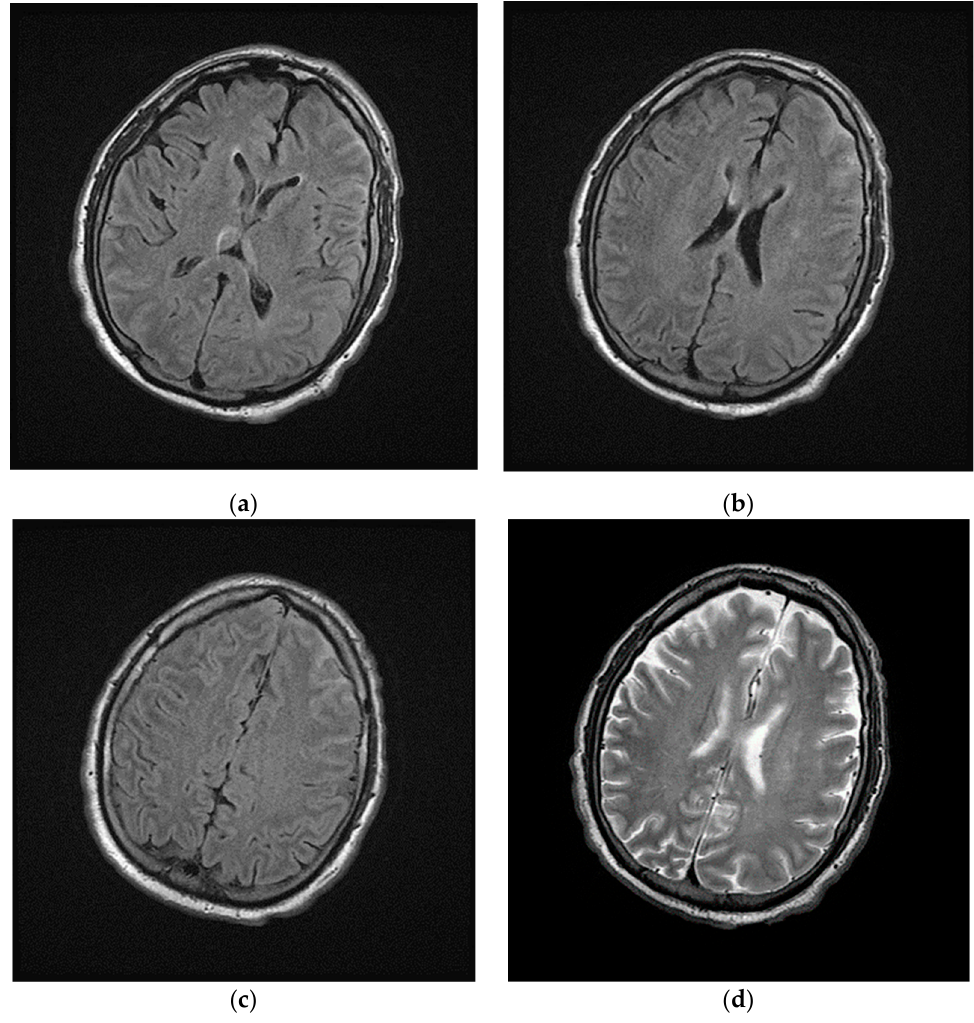
Figure 2. Magnetic Resonance Imaging (MRI) of brain performed during intensive care. ( a – c ) Axial fluid-attenuated inversion recovery (FLAIR) images and ( d ) axial T2w image show cerebrospinal fluid hyperintensities in the left frontal lobe; in the same images no focal lesions of the cerebral parenchyma were detected.